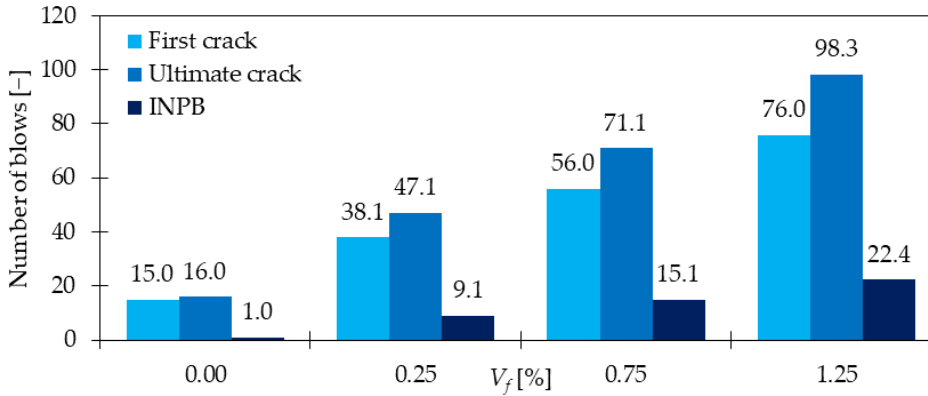
Figure 18. Impact resistance in relation to V f [91].